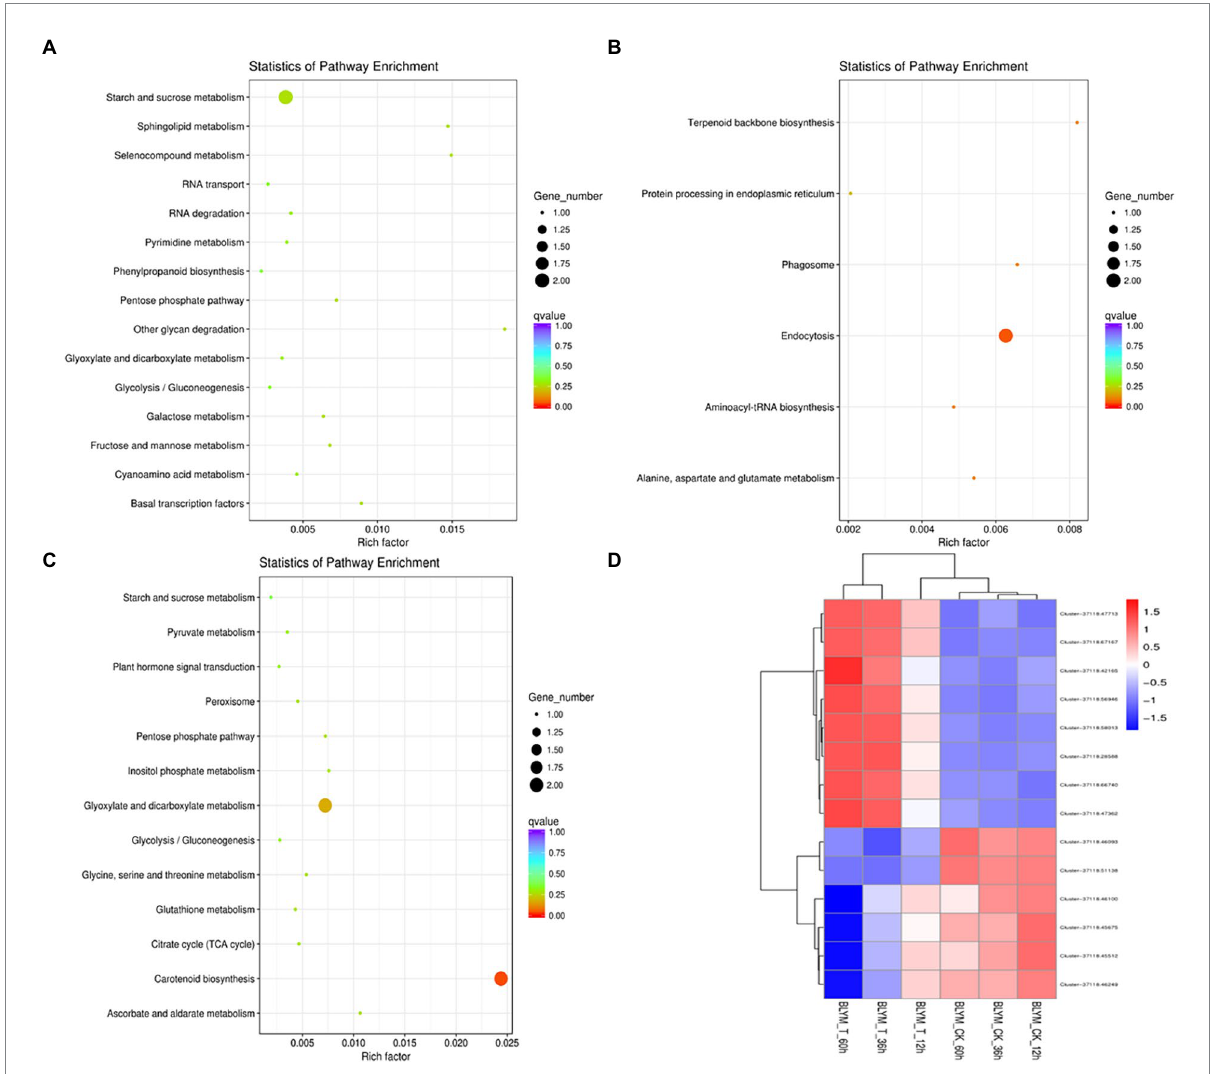
FIGURE 6 KEGG enrichment analysis and clustering analysis of Helictotrichon virescens hub genes from the brown (A) , blue (B) represents, and turquoise modules (C) . Cluster analysis representing the various hub genes (D)